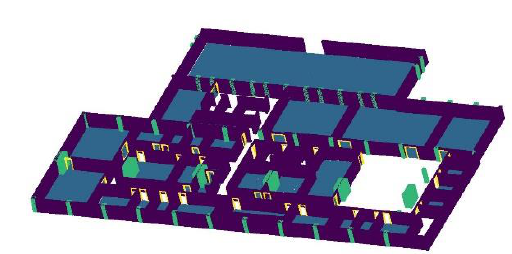
Figure 7. The synthetic point cloud generated from a CAD model.